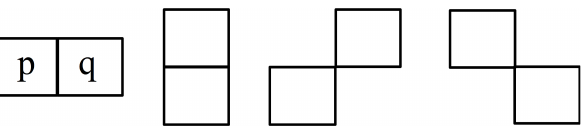
Figure 3. The 2 rand clique set.